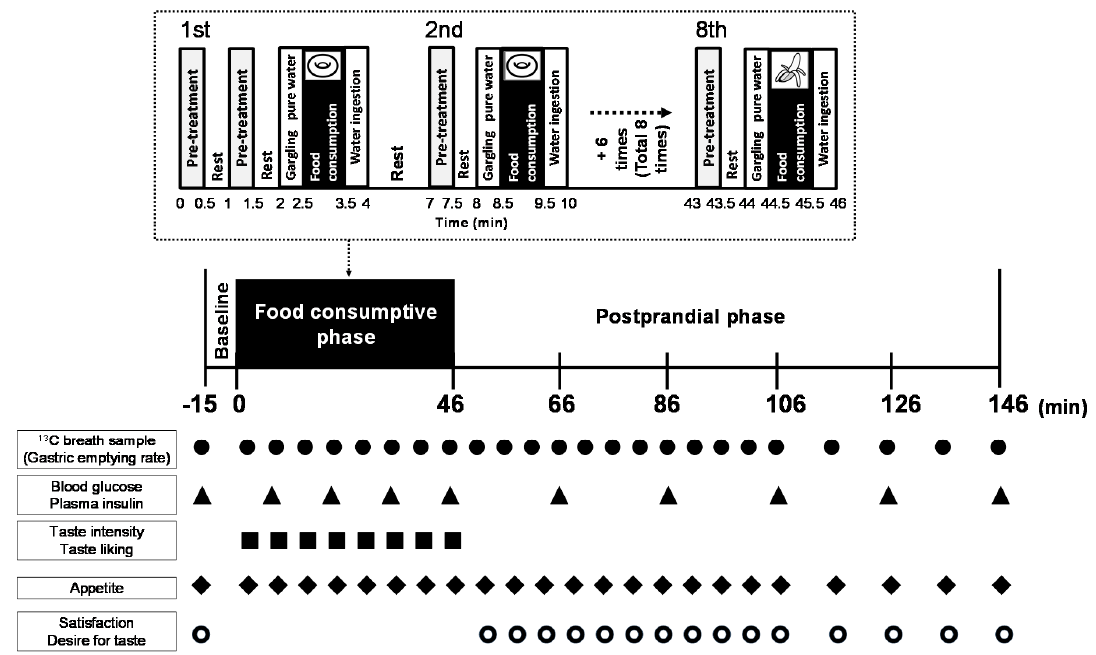
Figure 1. Scheme of the protocol of the study. Before consuming sweet-tasting food, participants rinsed their mouth for 0.5 min using 25 mL of distilled water or Gymnema sylvestre solution as pretreatment followed by a 0.5 min rest. These steps were repeated twice in the first step only. After that, the participants gargled with distilled water for 0.5 min, consumed a defined amount of sweet food for 1 min, and finally ingested water solution of 13 C-sodium acetate for 0.5 min. The protocol was repeated eight times for a total duration of 46 min (food consumption, i.e., prandial phase): muffin (first four times, yogurt with added sucrose (next two times) and banana (last two times). In the postprandial phase, participants rested for 100 min (i.e., from 46th to 146th min) following consumption of sweet-tasting food. The figure also indicates the timing of measurements and evaluations of gastric emptying rate, plasma glucose and insulin, taste intensity and taste liking, hunger, fullness, prospective consumption, satisfaction and desire for taste.